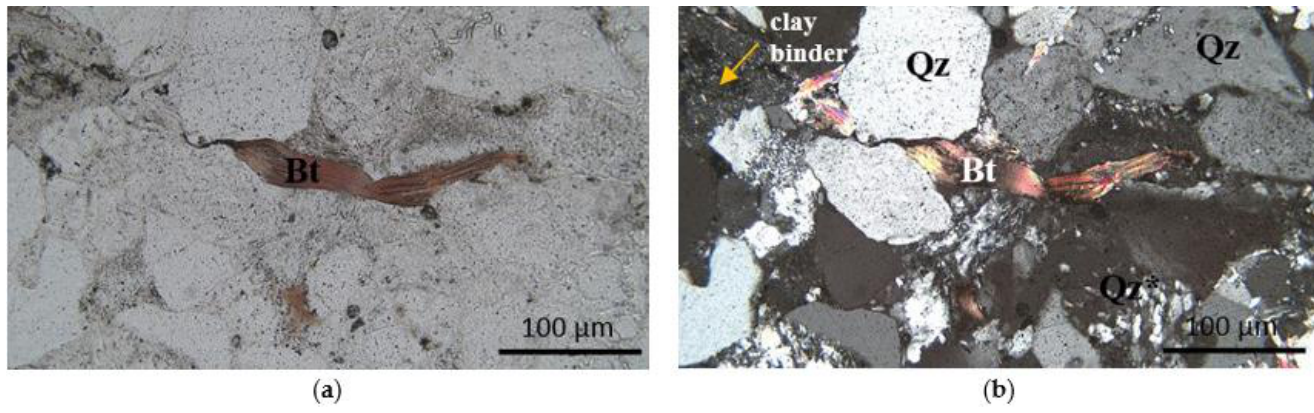
Figure 8. Muscovite (M s ) and quartz grains (Q z ): ( a ) one polar and ( b ) crossed polars—100× magnification.